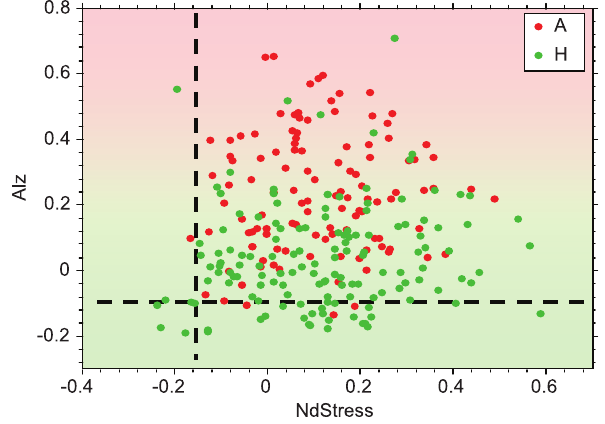
Figure 6. Comparison of NdStress and Alz in AD and HD. AD samples of PFC2 are colored in red. HD samples are colored in green. The reference biomarker scores corresponding to non demented individuals are represented by dashed lines.